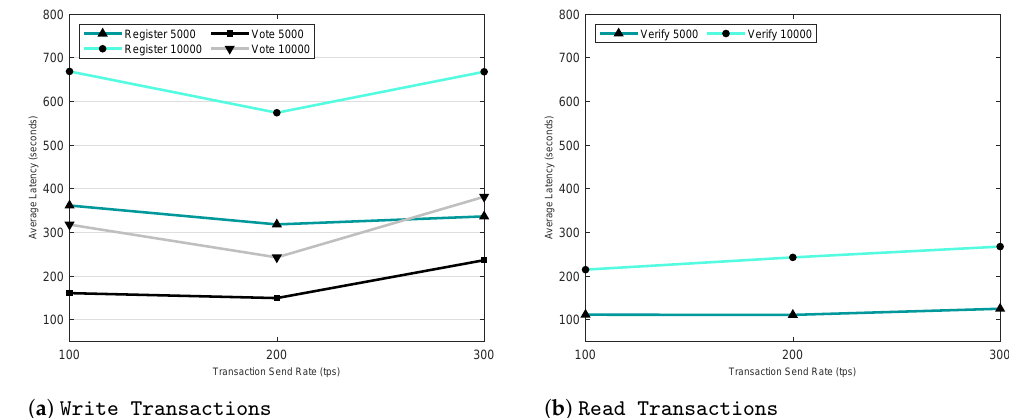
Figure 5. Impact of increasing the transaction rate and number of transactions on latency.